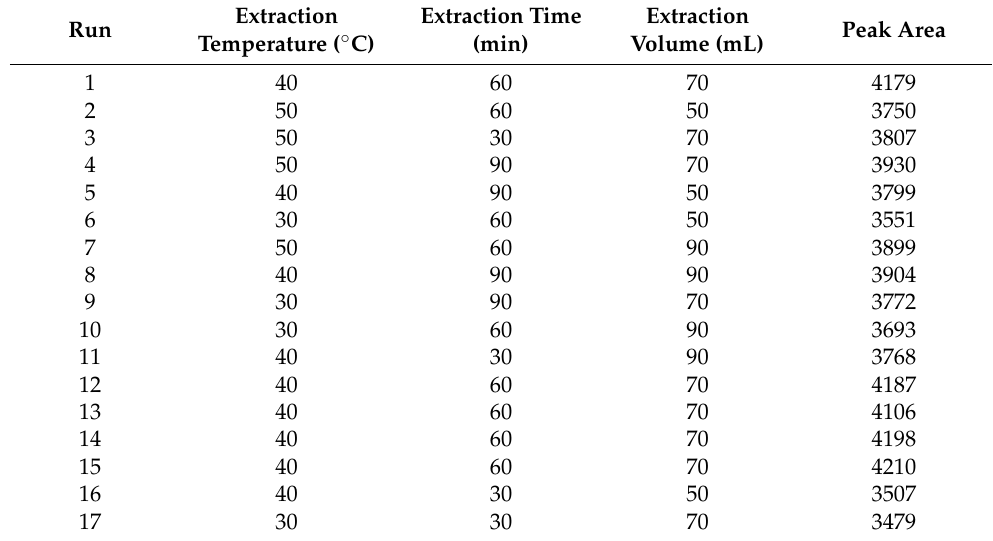
Table 3. The experimental design and data for UAE, obtained via BBD for fatty acids ( n = 3). Run